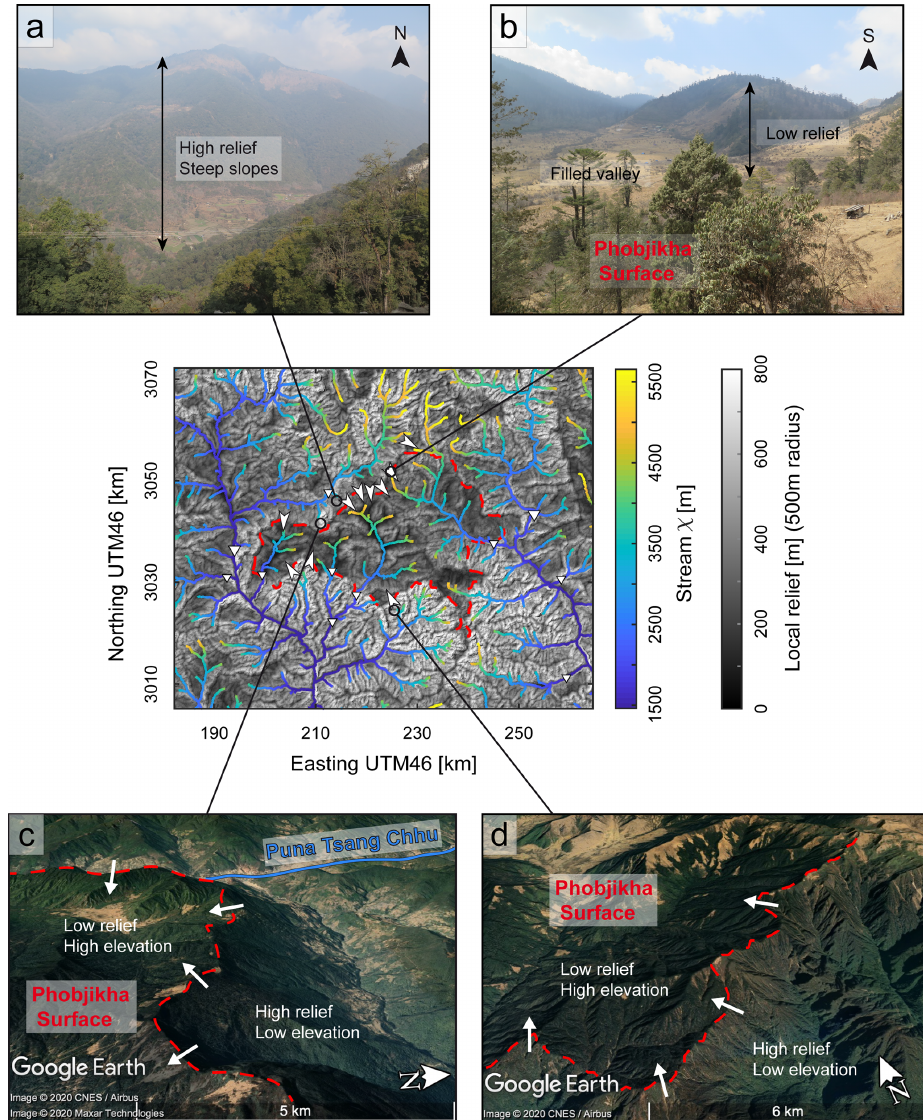
Figure 9. Divide mobility around the high-altitude low-relief Phobjikha region, from χ metrics, field and satellite observations. Central map (location on Fig. 1c) represents local relief, with a moving window of 500m, and the identified low-relief region is delimited by the red dashed line. Major knickpoints are reported with inversed triangles, and arrows locate the existence of morphological observations of regressive erosion (wind gaps), together with the direction of the associated divide migration. χ values are reported along the river network and are determined for a concavity of 0.5. Other complementary metrics of divide mobility are tested in Fig. S6. Similar observations are reported for the Yarab region (Fig. S7). Satellite observations are taken from the Google Earth database. (a) Field picture illustrating the high relief and steep slopes along the Dang Chhu (tributary of the Puna Tsang Chhu), along the northern boundary of the Phobjikha surface. Note the contrast in relief and slope with picture (b) , across the local delimitation of the Phobjikha surface. (b) Field picture looking east of the Pele La pass (northern part of the Phobjikha surface), where a filled valley is surrounded by higher-relief rims. Note the contrast in relief with picture (a) , across the local delimitation of the Phobjikha surface. (c) © Google Earth view (image from CNES – Airbus and Maxar Technologies 2020) of the relief and elevation contrasts across the northwestern drainage divide of the Phobjikha surface. White arrows locate observed beheaded channels (wind gaps) and indicate the direction of deduced drainage divide migration. (d) © Google Earth view (image from CNES – Airbus 2020) of the relief and elevation contrasts across the southern limit of the Phobjikha surface. White arrows locate observed beheaded channels and indicate the direction of deduced drainage divide